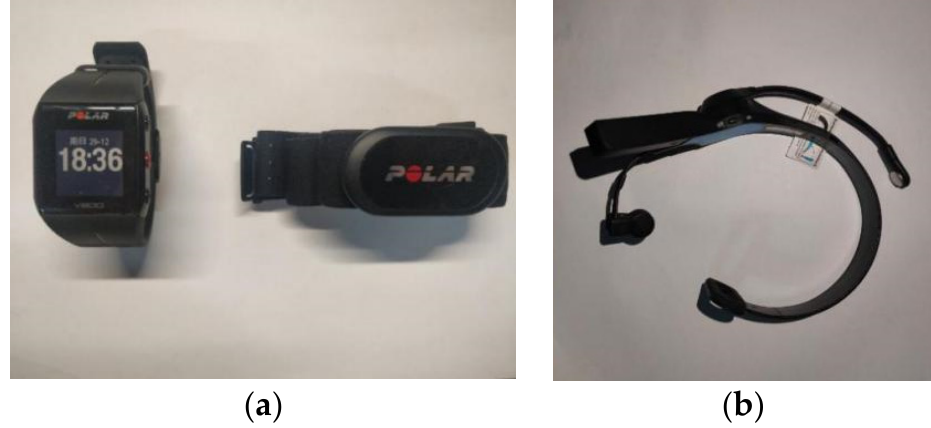
Figure 1. The bridge simulator room.